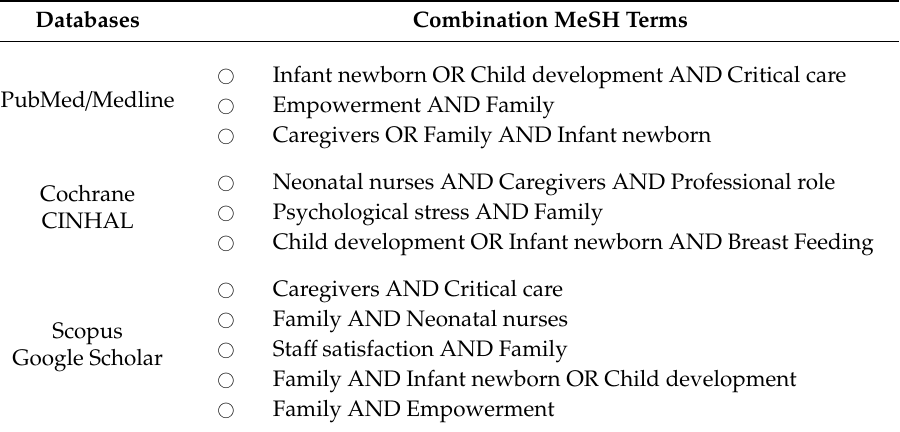
Table 1. Terminology used.